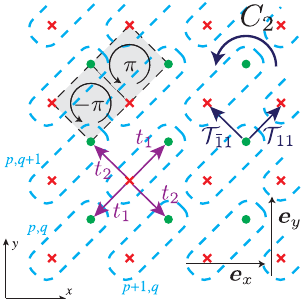
FIG. 6. Coupled Dirac wire model with tunneling amplitudes t 1 , t 2 . Each unit cell (dashed box) consists a pair of counter- propagating Dirac strings, and . T 11 ; T ¯11 are the two antiferromagnetic